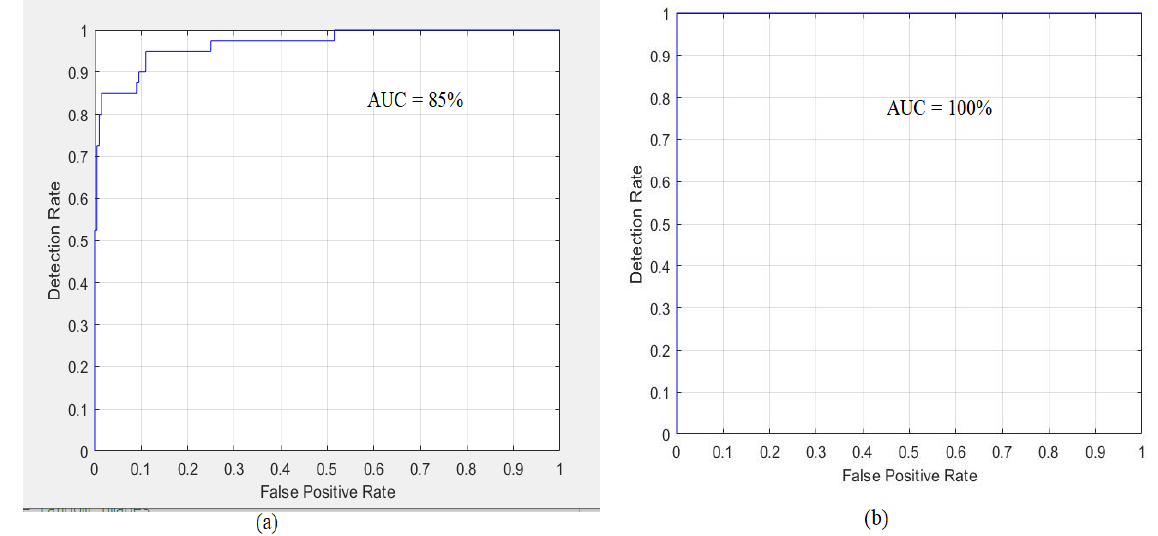
Figure 20. The ROC values reached by the ResNet-50 model considering the different datasets used. ( a ) The ISIC 2018 dataset. ( b ) The PH2 dataset.